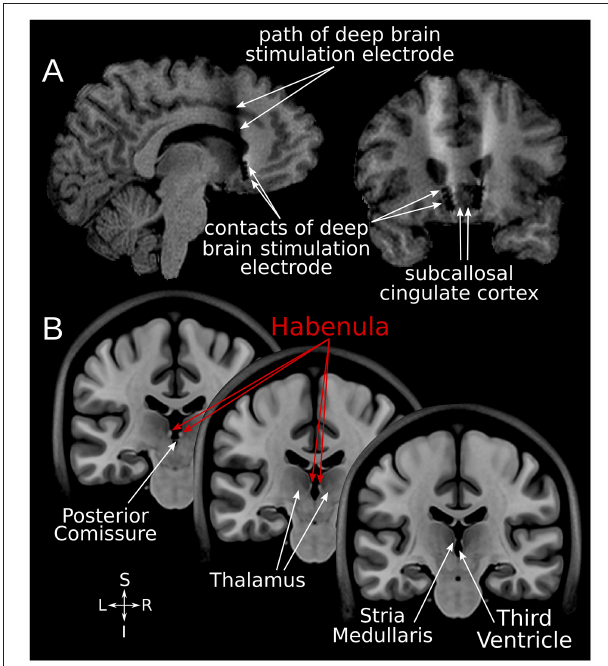
FIGURE 1 | SCC-DBS and the habenula. (A) Sagittal and coronal structural T1-weighted MRI slices from an exemplar patient showing the position of the implanted bilateral electrodes. These are placed in the white matter bordering the subcallosal cingulate cortex. (B) Coronal slices of the asymmetrical MNI152 template (42) illustrating the location of the habenula and surrounding structures. The habenula appears bright (hyperintense) on T1-weighted MRI. DBS , deep brain stimulation; MNI , Montreal Neurological Institute; SCC , subcallosal cingulate area.